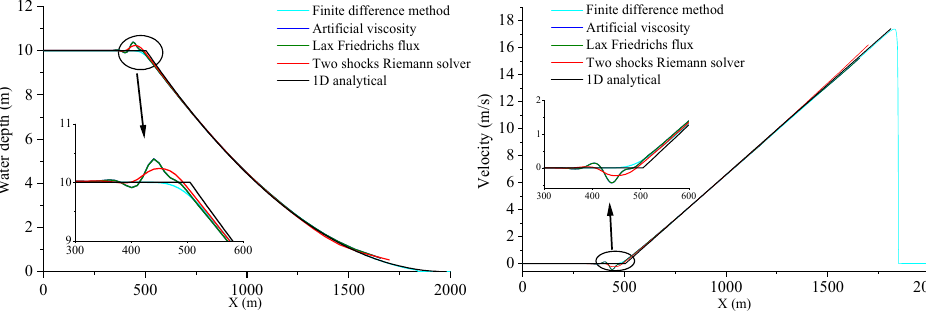
Figure 3. Simulation results of different processing methods.